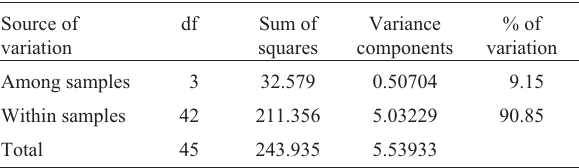
Table 3 - Analysis of molecular variance (AMOVA) using 147 RAPD loci, partitioning genetic variation within and between samples of H. ancistroides from four sites on the Cambé stream.